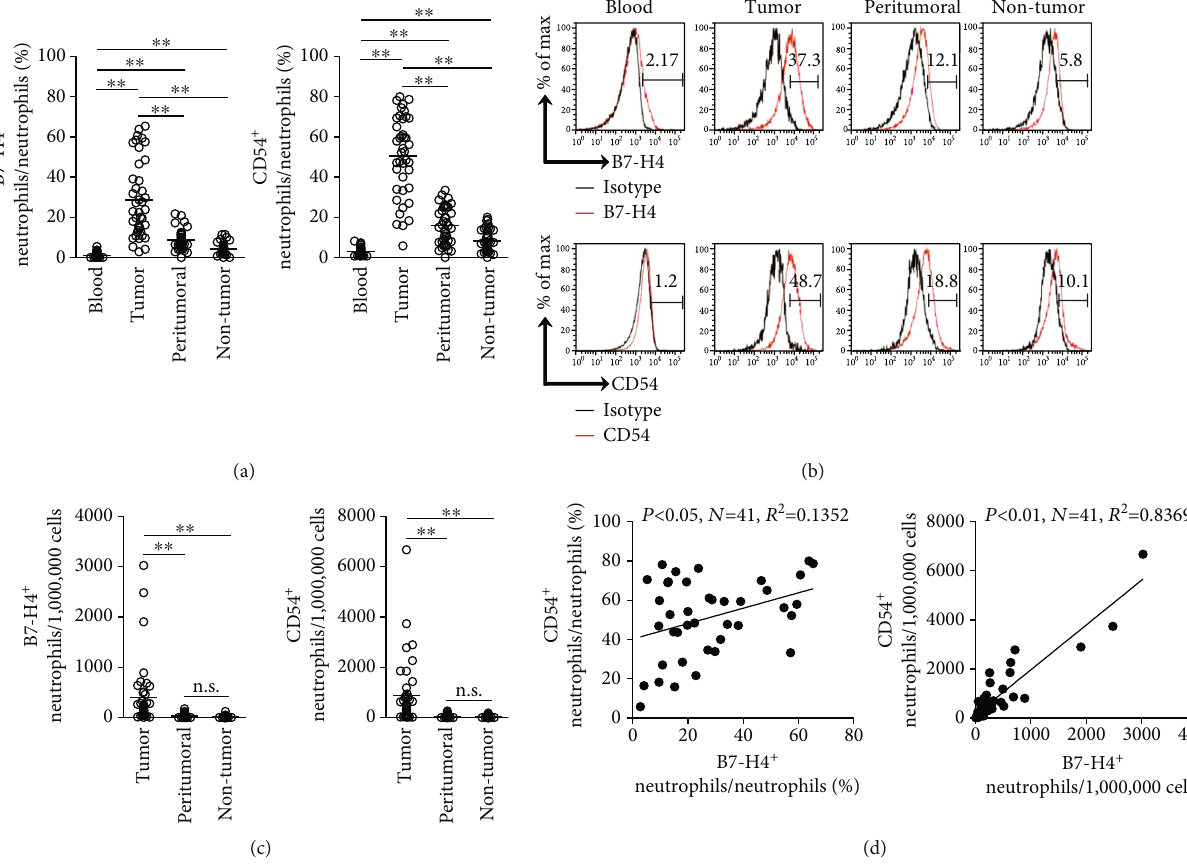
Figure 2: B7-H4 expression and activation of neutrophils are correlated in human GC environment. (a) Statistics analysis of the percentage of CD54 + neutrophils and B7-H4 + neutrophils in total neutrophils in each sample of patients with GC ( n = 41 ). (b) Expression of molecules CD54 and B7-H4 on neutrophils. Color histograms represent staining of neutrophil activation marker CD54 and immunosuppressive molecule B7-H4; black: isotype control. (c) Statistics analysis of the number of CD54 + neutrophils and B7-H4 + neutrophils per million total cells in each sample of patients with GC ( n = 41 ). (d) The correlations between CD54 + neutrophils and B7-H4 + neutrophils in GC tumors were analyzed. Results are expressed as the percentage of CD54 + neutrophils and B7-H4 + neutrophils in neutrophils or the number of CD54 + neutrophils and B7-H4 + neutrophils per million total cells in tumor tissues of patients with GC. The horizontal bars in (a) and (c) represent mean values. Each ring or dot in (a), (c), and (d) represents 1 patient. ∗ P < 0 : 05 , ∗∗ P < 0 : 01 , and n.s. P > 0 : 05 for groups connected by horizontal